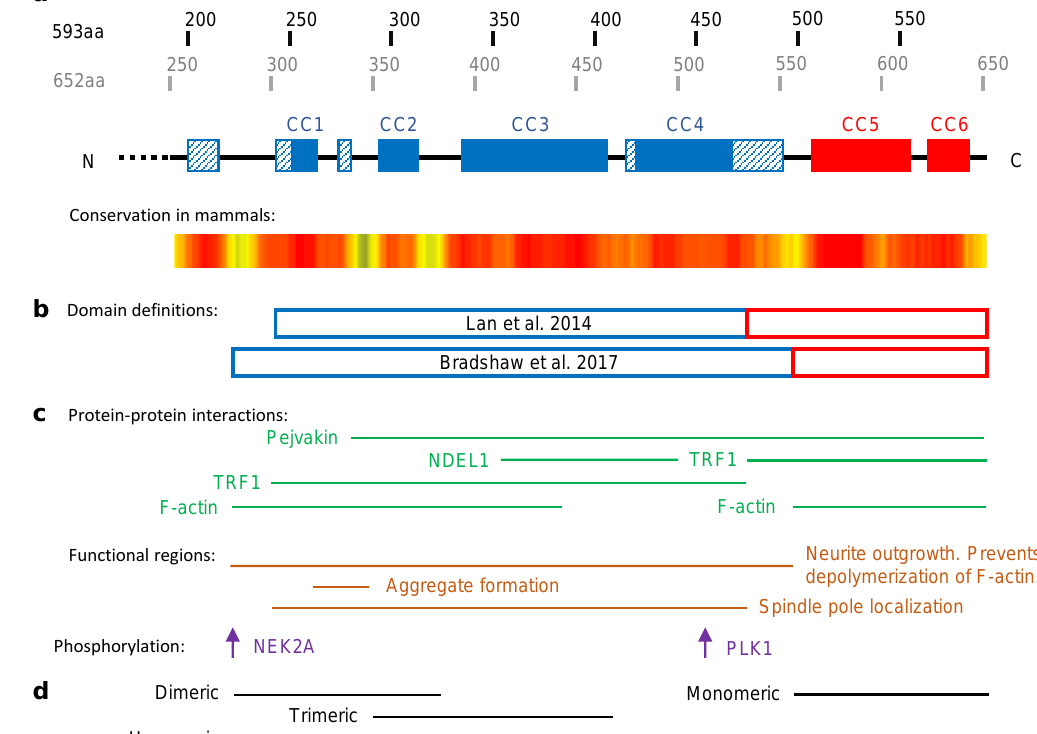
Figure 3. The structure of the coiled-coil regions of TRIOBP-1. All parts of this figure are to scale with each other. ( a ) Locations of predicted coiled-coils (CC). Solid filled boxes represent high confidence predictions, striped boxes represent lower confidence predictions, derived from PSIRPED [9]. CCs are colored based on their predicted inclusion in the central CC domain (blue) or C-terminal CC domain (red). Amino acid numbering from both the 593 amino acid and 652 amino acid TRIOBP-1 proteins are shown. Labeling of CCs is based on Bradshaw et al. [12] and di ff ers from the numbering used by Katsuno et al. [18], who do not count the putative coiled-coil labeled here as CC1 in their numbering. Level of amino acid conservation is displayed using the same calculation and heat map as in Figure 1c. ( b ) Locations of constructs representing the central and C-terminal CC domains from two publications [12,14]. ( c ) Locations of regions of TRIOBP-1 involved in protein–protein interactions and functions [3,12,14,19,20]. Note that some proteins bind more than one region of TRIOBP-1. The only proteins so far reported to bind to TRIOBP-1 outside of these CC regions is TRIO, which binds to the mid domain between the central CC region and the PH domain [13]. The locations of two known phosphorylated residues and their associated kinases are also shown [14,21]. ( d ) Locations of fragments of TRIOBP-1 and the oligomeric states they adopt when expressed in isolation in vitro